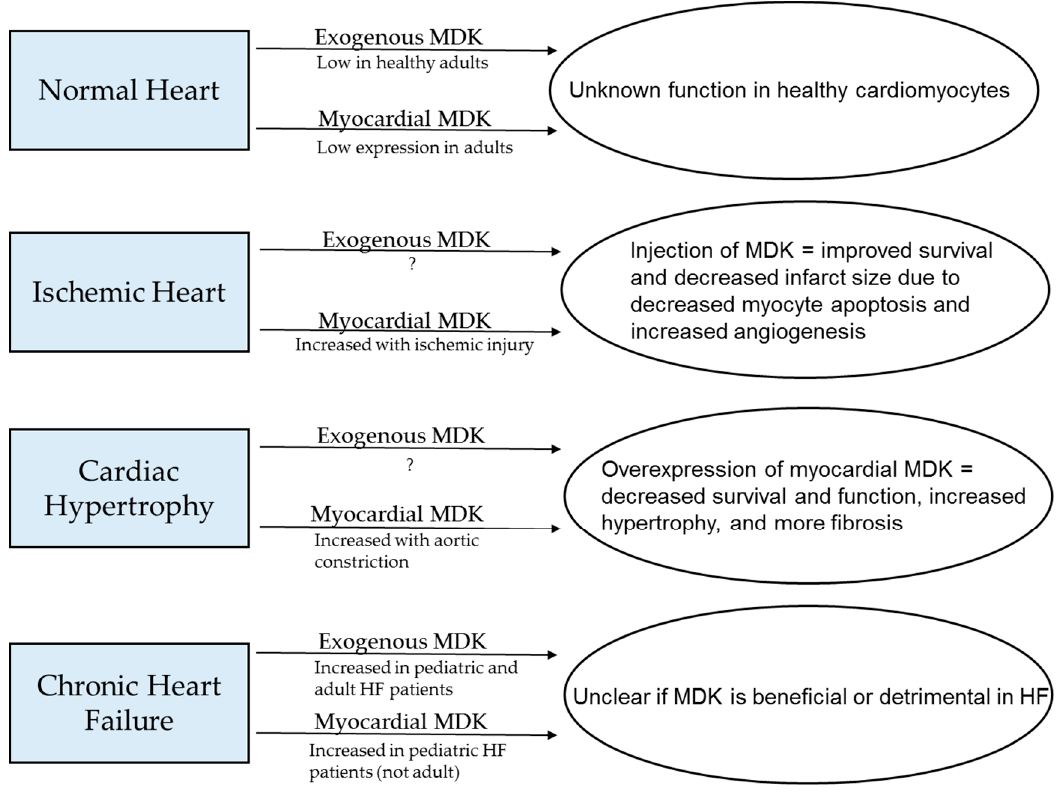
Figure 3. Summary of what is known about levels of circulating and myocardial MDK in normal hearts and several cardiac pathologies and how these factors affect cardiac outcomes.